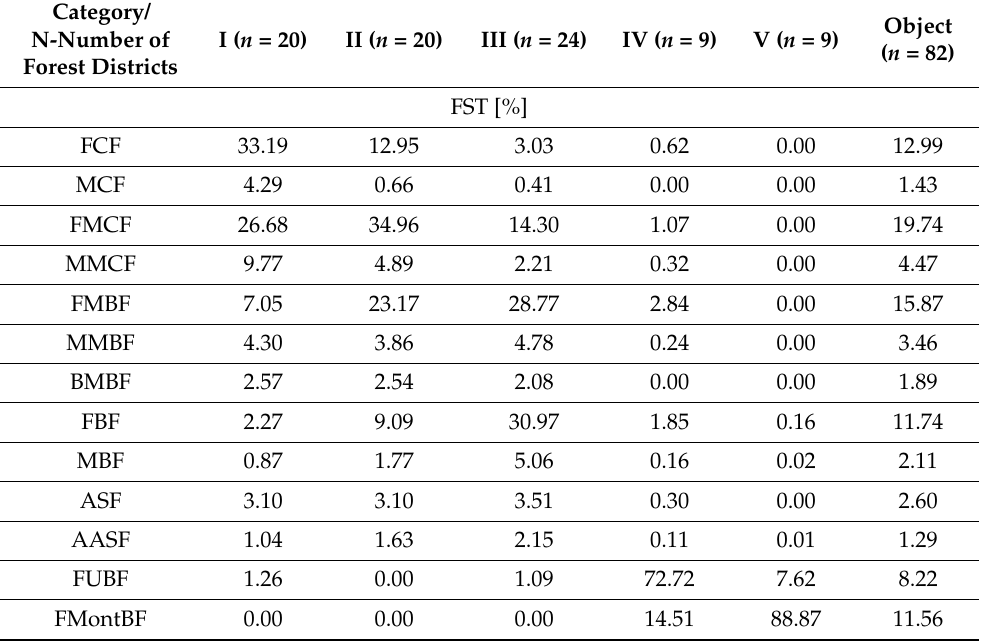
Table A1. Categories of forest districts distinguished due to the percentage share of forest site types (FST).